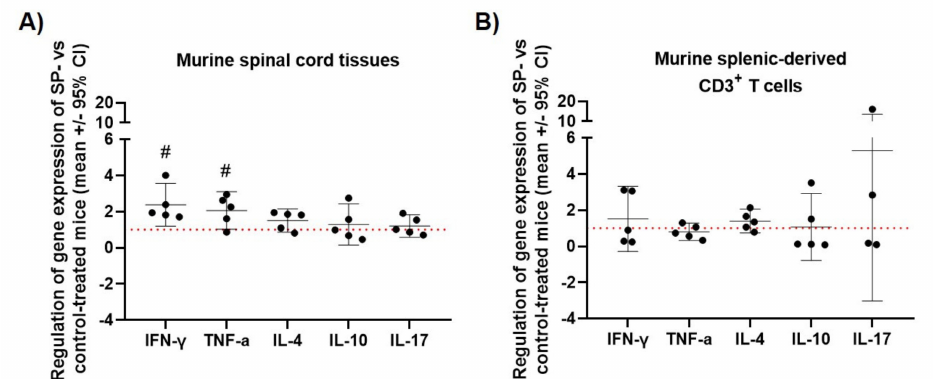
Figure 3. E ff ect of SP treatment on relative cytokine mRNA expression in ( A ) murine spinal cord of MOG 35-55 EAE-diseased mice (acute phase) and in ( B ) murine splenic-derived CD3 + T cells of MOG 35-55 EAE-diseased mice (acute phase). ( A , B ) X-fold di ff erence in the relative expression of INF- γ , TNF- α , IL-4, IL-10 and IL-17 (normalized to Rps18) in SP 30 mg / kg / day-treated mice compared to control mice. Control ( n = 5, in triplicates), SP 30 mg / kg / day ( n = 5, in triplicates) and 3 days of treatment. qRT-PCR. Abbreviations: SP: SP600125, CI: Confidence of interval. Statistic: One-sample t-test # <